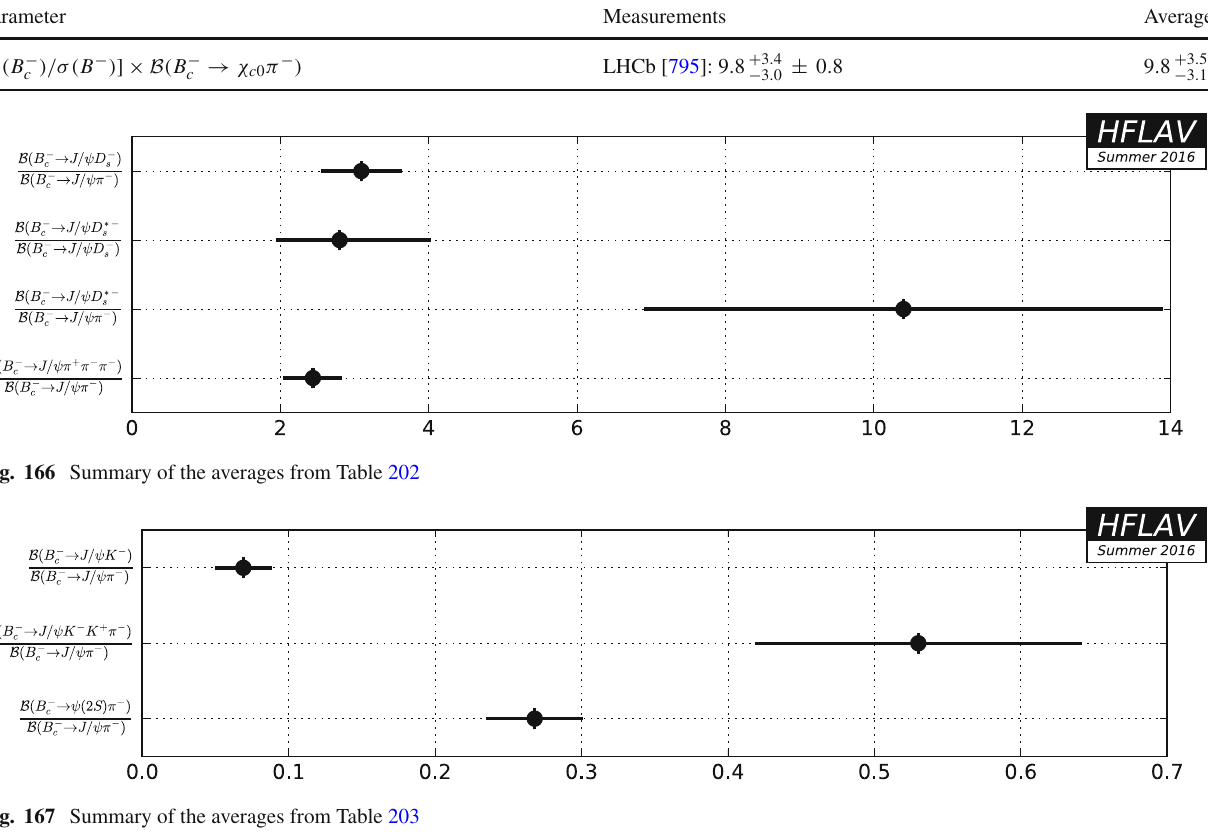
Table 205 Decay rates times relative production rates [ 10 − 6 ]